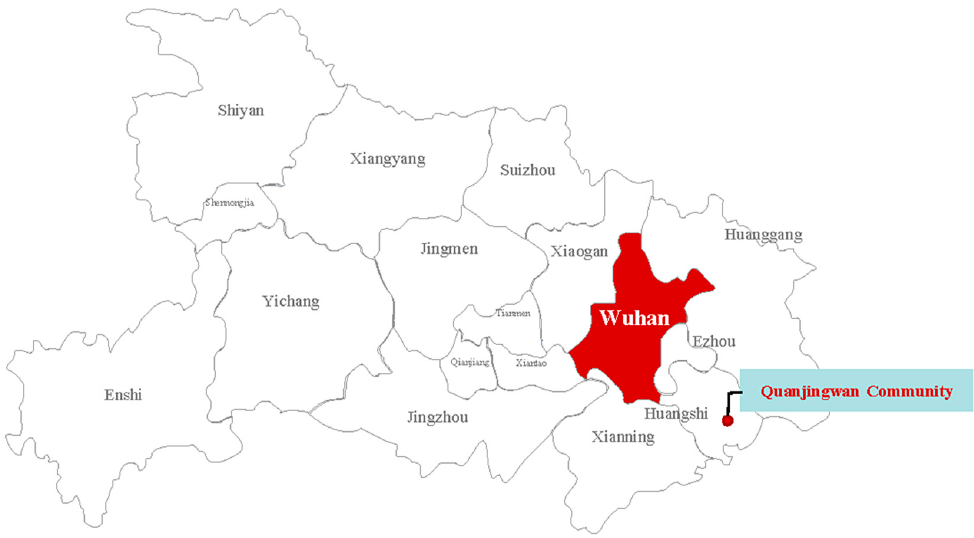
Figure 1. The geographical position of Quanjingwan community in Hubei Province, China.